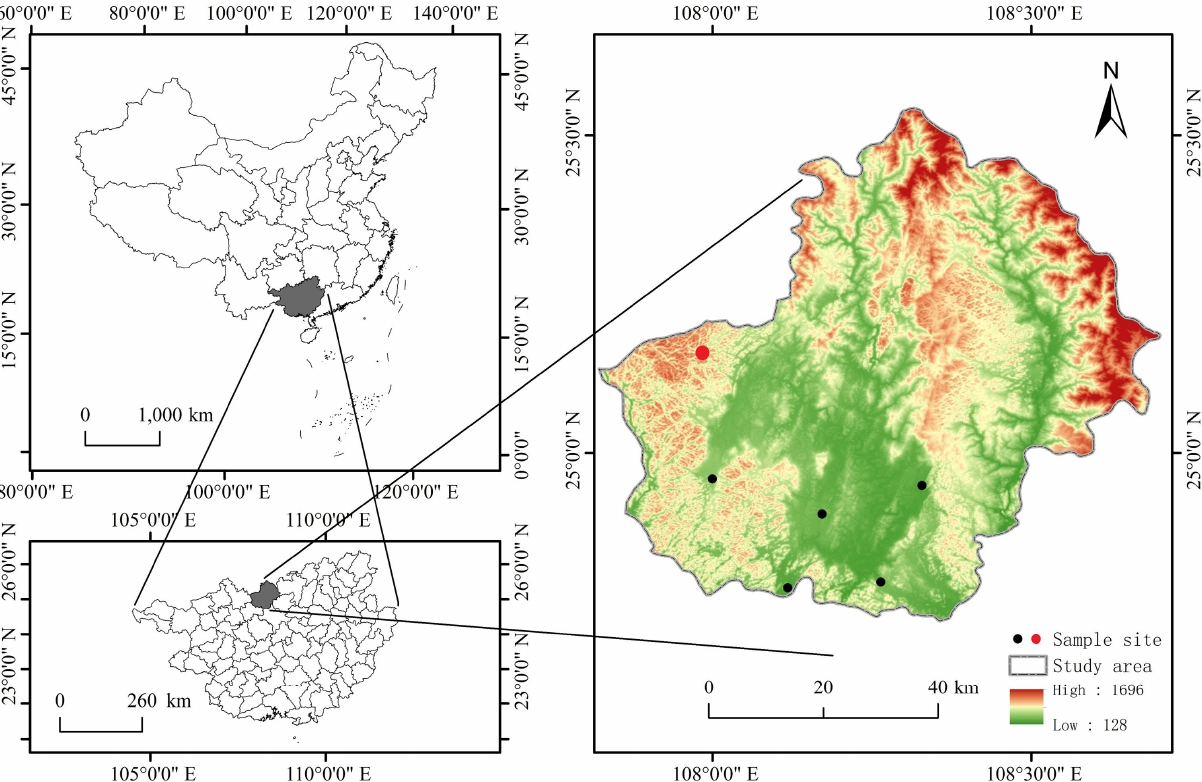
Figure 1. Map of the study area and locations of sample sites. The two maps on the left indicate China and Guangxi Province, and the map on the right indicates Huanjiang County. In the key, high/low indicates altitude (m a.s.l.). The black dot indicates the location of the farmland sample site. The red dot indicates the location of the forest sample site. In each sample site, five land-use types (cropland, sugarcane, mulberry, forage grass, and mature forest) were selected.